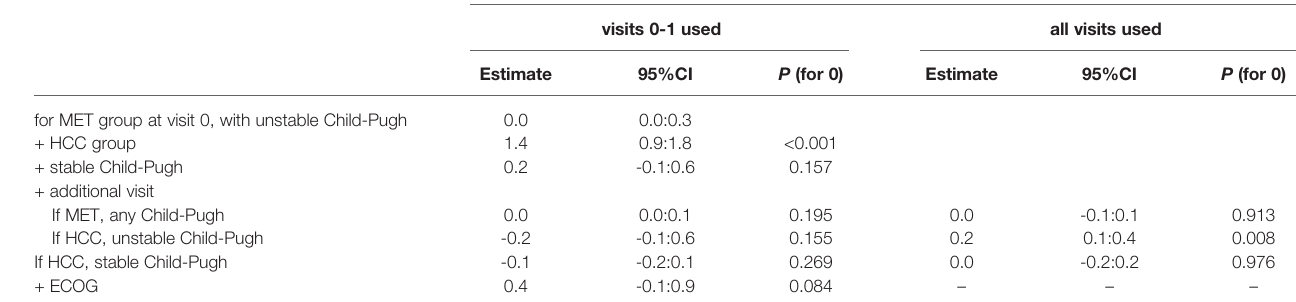
Total Tumor Size at Baseline (normalized), Largest Tumor Size at Baseline (normalized), Number of Tumors at Baseline, TACE type, Microcatheter Location, Vascular Invasion, AFP and MELD dropped during model selection per AIC; dashed lines indicate that the corresponding variable was selected out by the model selection process as unimportant. Visit = TACE